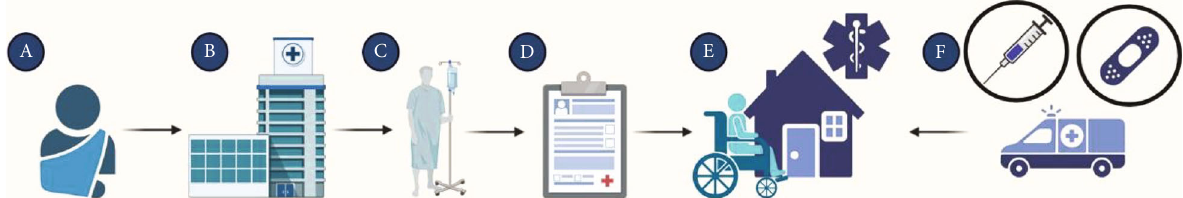
Figure 2: Patient transit fl ow chart. (a) The patient is sent to the ED after a clinic visit, where skin changes of the left foot were noticed. (b) The patient is hospitalized and evaluated by the podiatrist at Mayo Clinic Health Systems, Eau Claire, Wisconsin. (c) The patient is recommended to undergo the surgical procedure. (d) The family denies further procedures. The medical team consults the ACH team. The patient meets the criteria to be admitted to the program. (e) The patient is transported home, where the technological kit is given. (f) The command center located in Jacksonville, Florida, evaluated the patient daily. Additionally, a medical team visited the patient ’ s home to administer antibiotics, perform a vascular assessment with a Doppler, and change the dressing of the